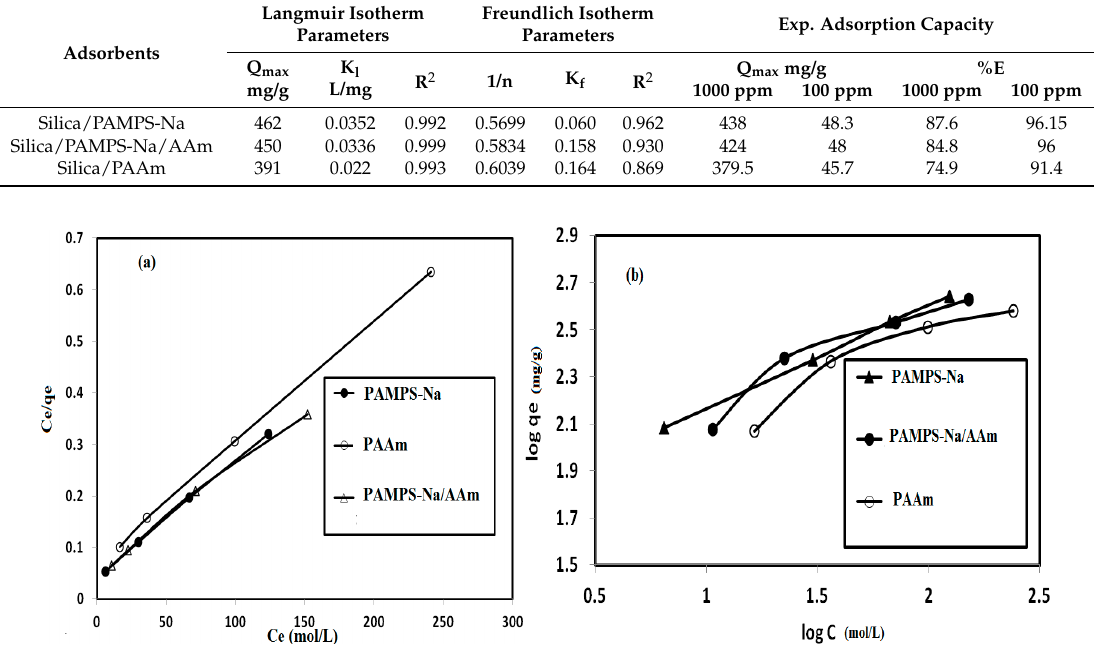
Figure 7. Adsorption isotherms ( a ) Langmuir and ( b ) Freundlich models of silica-nanogel composites. Table 5. Adsorption isotherm parameters for removal of 1000 ppm of MB dye using silica nanogels at 25 °C.